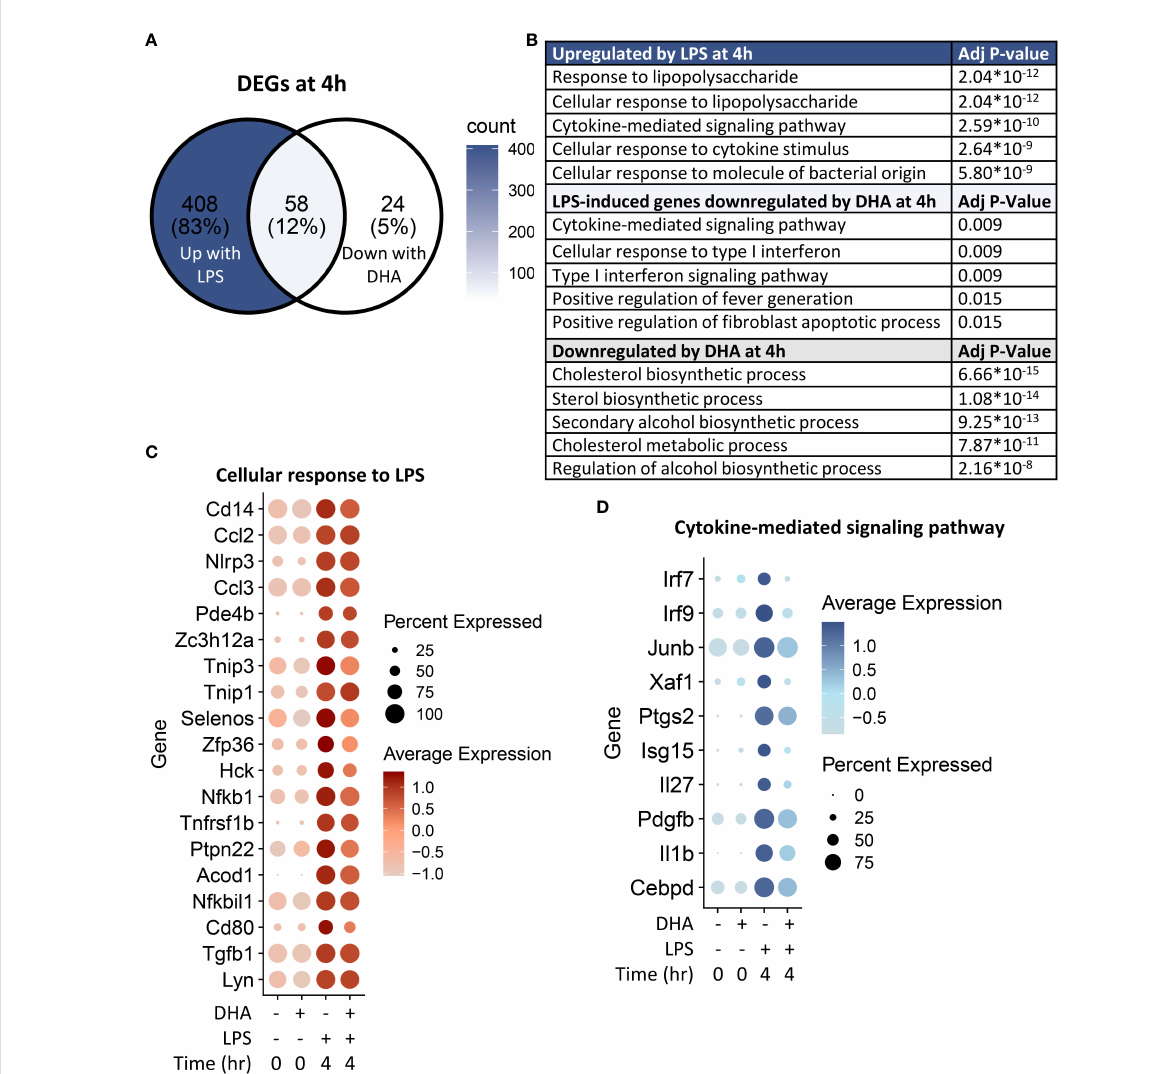
dimerizes with the NF- k B p65 subunit, forming the most abundant of the Rel/NF- k B heterodimers (70, 71). DHA suppressed the Rel and NF- k B regulons at 4 h, though not completely (Figure 10B). Although the Irf7, Stat1, and Stat2 regulons were increased to a lesser extent than the Rel and NF- k B regulons, they were almost completely ablated by DHA. When investigating the regulon scores for individual cells,